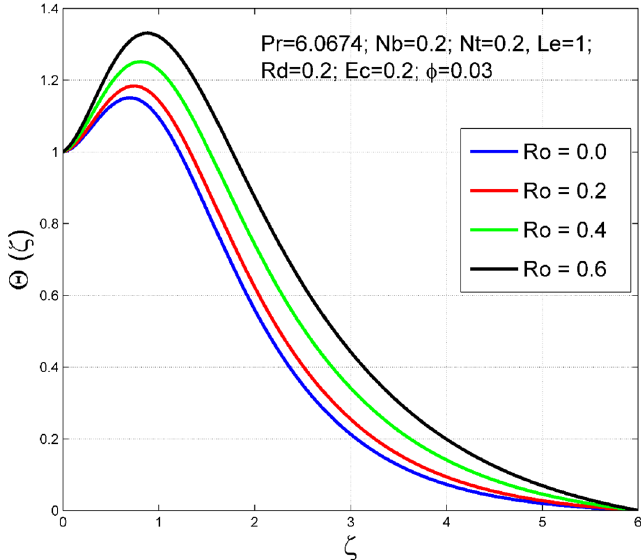
Figure 5. Effect of Ro on �(ζ) .